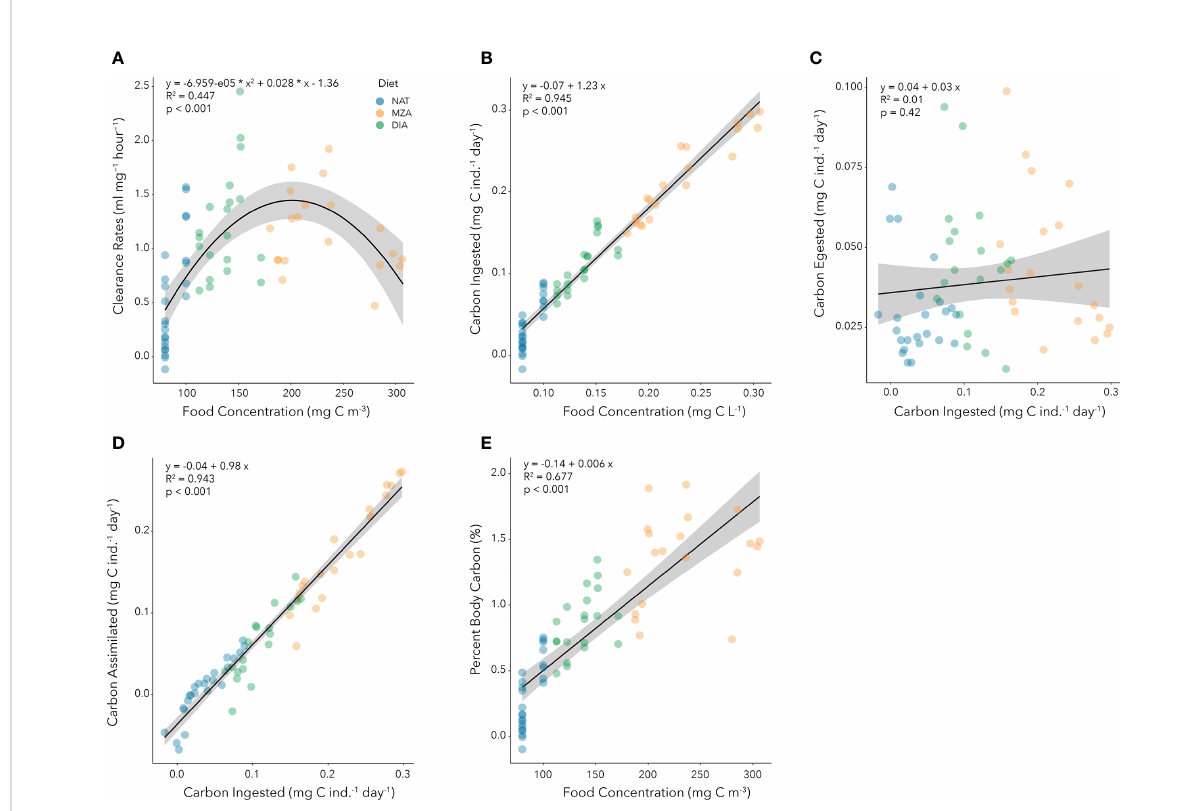
FIGURE 4 Functional responses of juvenile krill provided natural seawater assemblage (NAT), the addition of a freeze-dried mixed zooplankton assemblage (MZA), and the addition of cultured diatoms (DIA). (A) Relationship between clearance rate [ F , mL (mg DW) -1 hour -1 ] and food concentration (mg C m -3 ). The second-order polynomial regression equation is provided, as are the adjusted r-squared and p-values. (B) Relationship between carbon ingested (I, mg C ind. -1 day -1 ) and food concentration (mg C L -1 ). The linear regression equation is provided, as are the adjusted r- squared and p-values. (C) . Relationship between carbon egested (E, mg C ind. -1 day -1 ) and carbon ingested (I, mg C ind. -1 day -1 ). The linear regression equation is provided, as are the adjusted r-squared and p-values. (D) Relationship between carbon assimilated ( A , mg C ind. -1 day -1 ) and carbon ingested (I, mg C ind. -1 day -1 ). The linear regression equation is provided, as are the adjusted r-squared and p-values. (E) Relationship between percent body carbon ingested, or daily ration (DR, % day -1 ) and food concentrations (mg C m -3 ). The linear regression equation is provided, as are the adjusted r-squared and